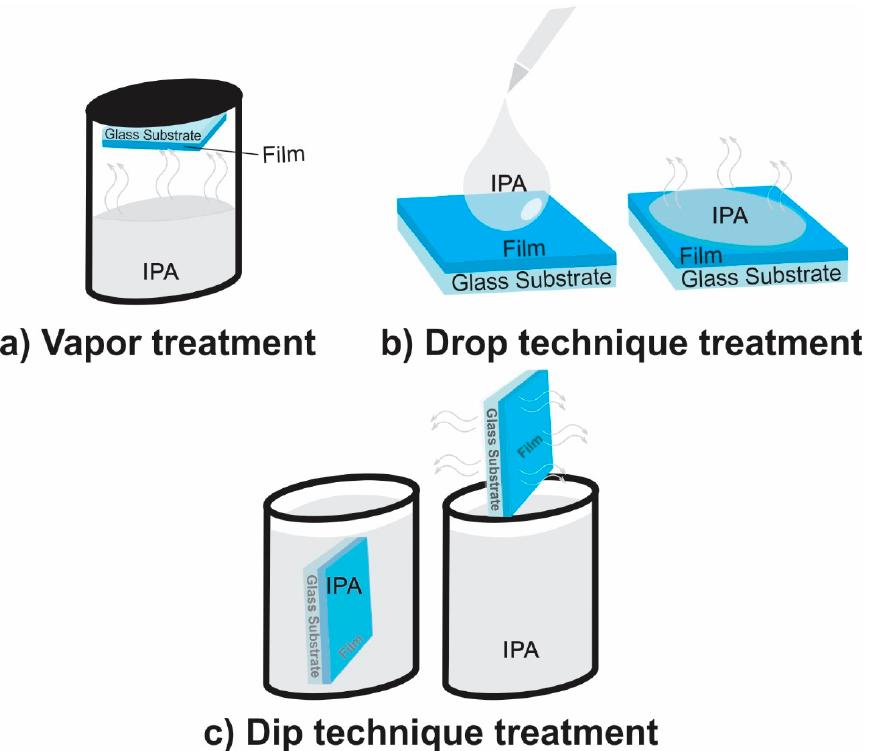
Figure 2. Schematic illustration of different solvents treatments used in this work: ( a ) vapor, ( b ) drop, and ( c ) dip techniques.